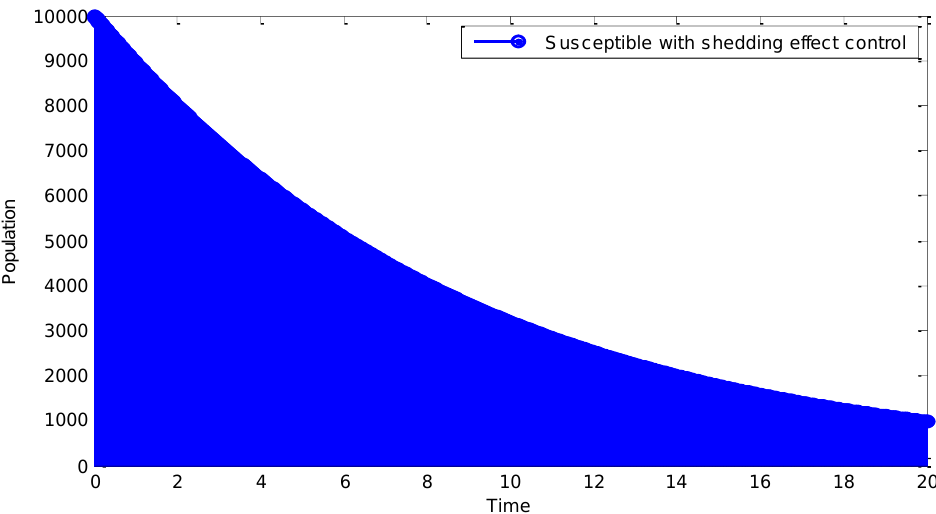
Figure 3. Dynamics of susceptible population with control.